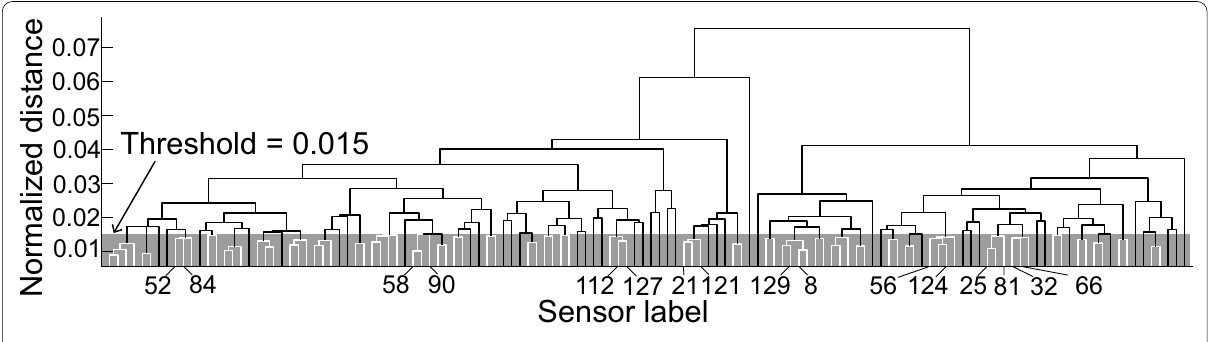
Fig. 13 Dendrogram of sensor